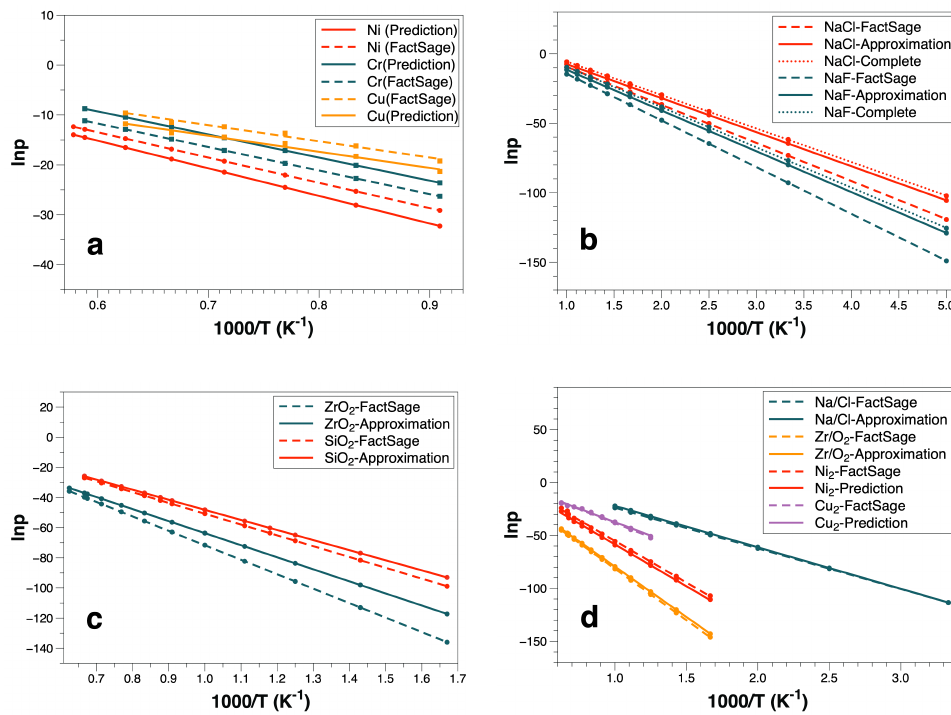
Figure 1. Comparison of the results: ( a ) Monoatomic molecules, ( b ) monoatomic molecule ap- proximation and complete model, ( c ) monoatomic molecule approximation for triatomic molecules, ( d ) chemical